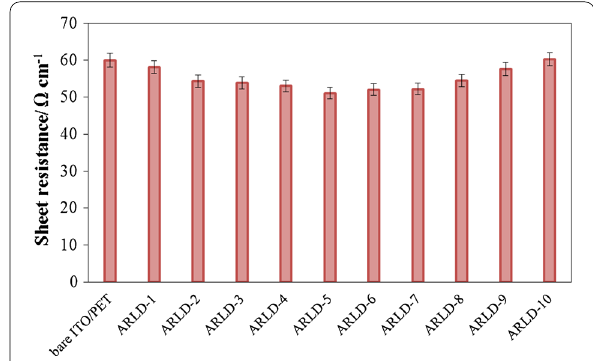
Fig. 2 The sheet resistance changes of ITO/PET electrode samples layered by (ARS/LDHs)